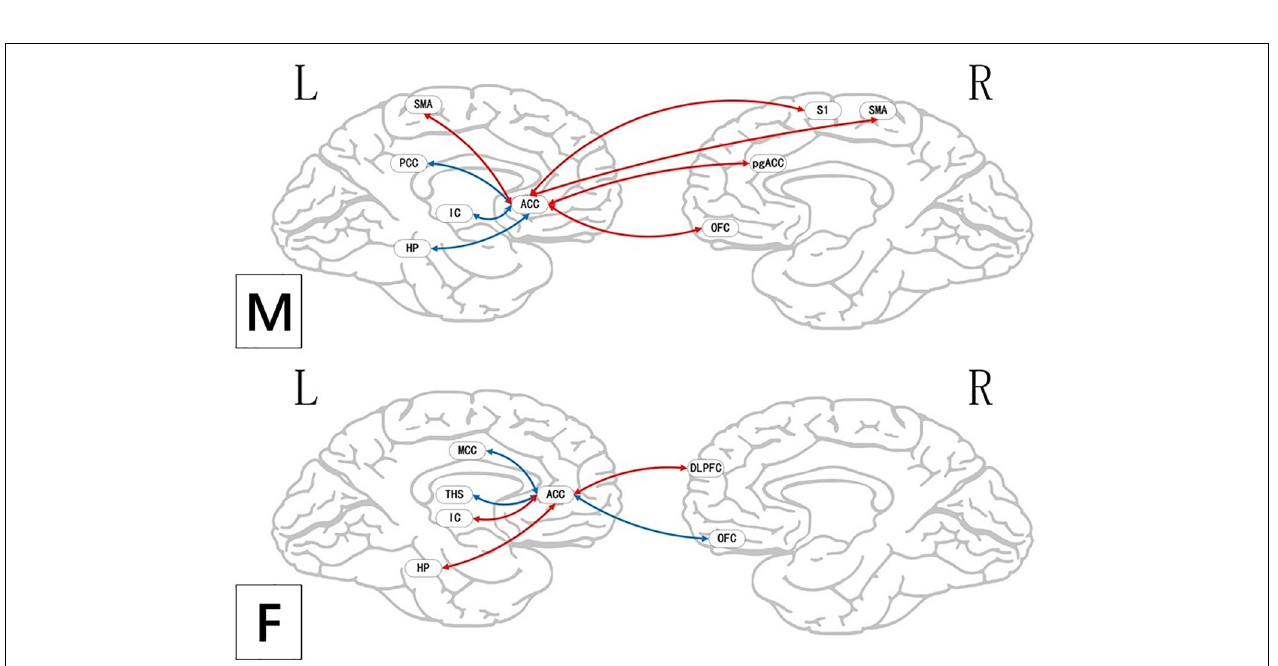
FIGURE 9 | Regions showing significantly functional connectivity state differences in the two groups, when male or female participants (nocebo response) compare their own pain status. M: Compared with female participants, male participants of nocebo response had unique functional connectivity in the brain network; F: compared with male participants, female participants of nocebo response had unique functional connectivity in the brain network. Some brain regions only showed projection position. Red = nocebo > pain; blue = pain > nocebo. L, left hemisphere; R, right hemisphere; OFC, orbitofrontal cortex; DLPFC, dorsolateral prefrontal cortex; VMPFC, ventromedial prefrontal cortex; TP, temporal pole; HP, hippocampus gyrus; PHP, parahippocampal gyrus; pgACC, pregenual anterior cingulate cortex; IC, insular; MCC, mid-cingulate cortex; PCC, posterior cingulate cortex; THS, thalamus; SMA, supplementary motor area; S1, primary somatosensory area; S2, secondary somatosensory area; AG, angular